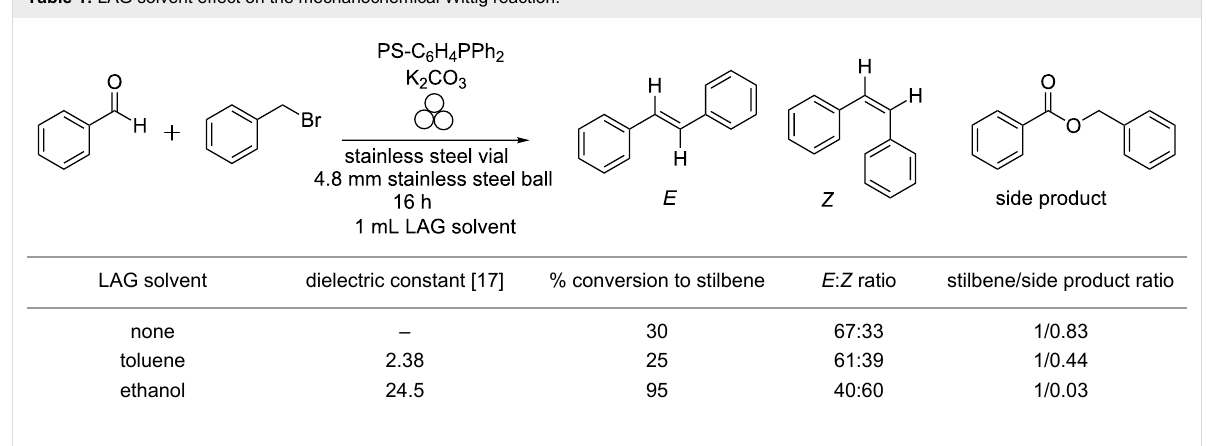
Table 1: LAG solvent effect on the mechanochemical Wittig